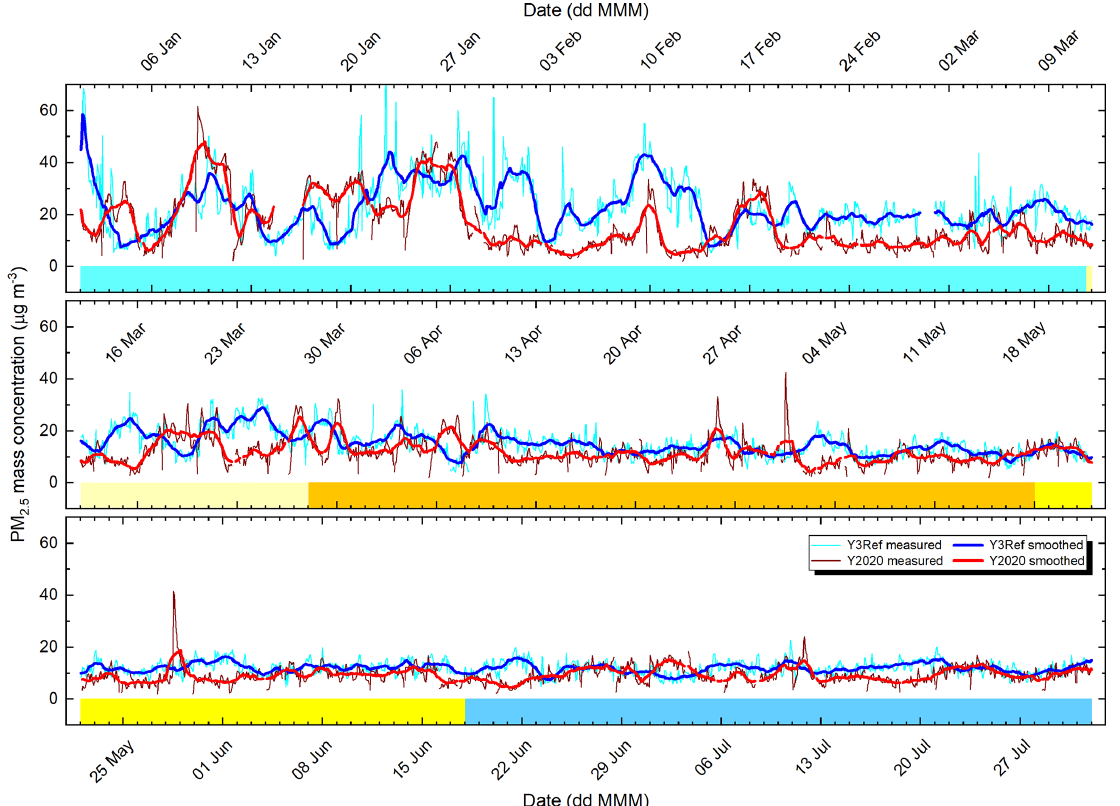
Figure 5. Time series of PM 2 . 5 mass concentration in the average reference year comprising 2017–2019 (Y3Ref) and year 2020 together with their 24h smoothed curves over the five consecutive phases of the first COVID-19 outbreak. The phases are marked by the following colour codes: Pre-emergency phase lighter blue, Pre-restriction phase lighter yellow, Restriction phase orange, Post-restriction phase darker yellow and Post-emergency phase darker blue. The tick labels of the abscissa indicate the Mondays in